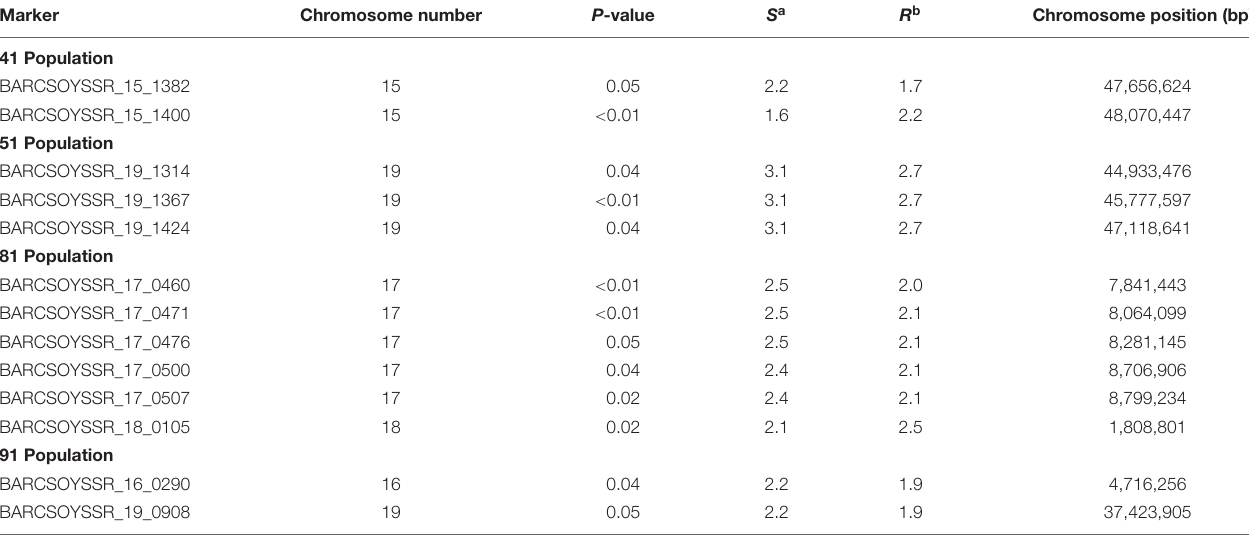
TABLE 4 | Significant genetic markers identified in the analysis of the four populations evaluated for Sclerotinia stem rot severity in 2013 greenhouse evaluations. Marker Chromosome